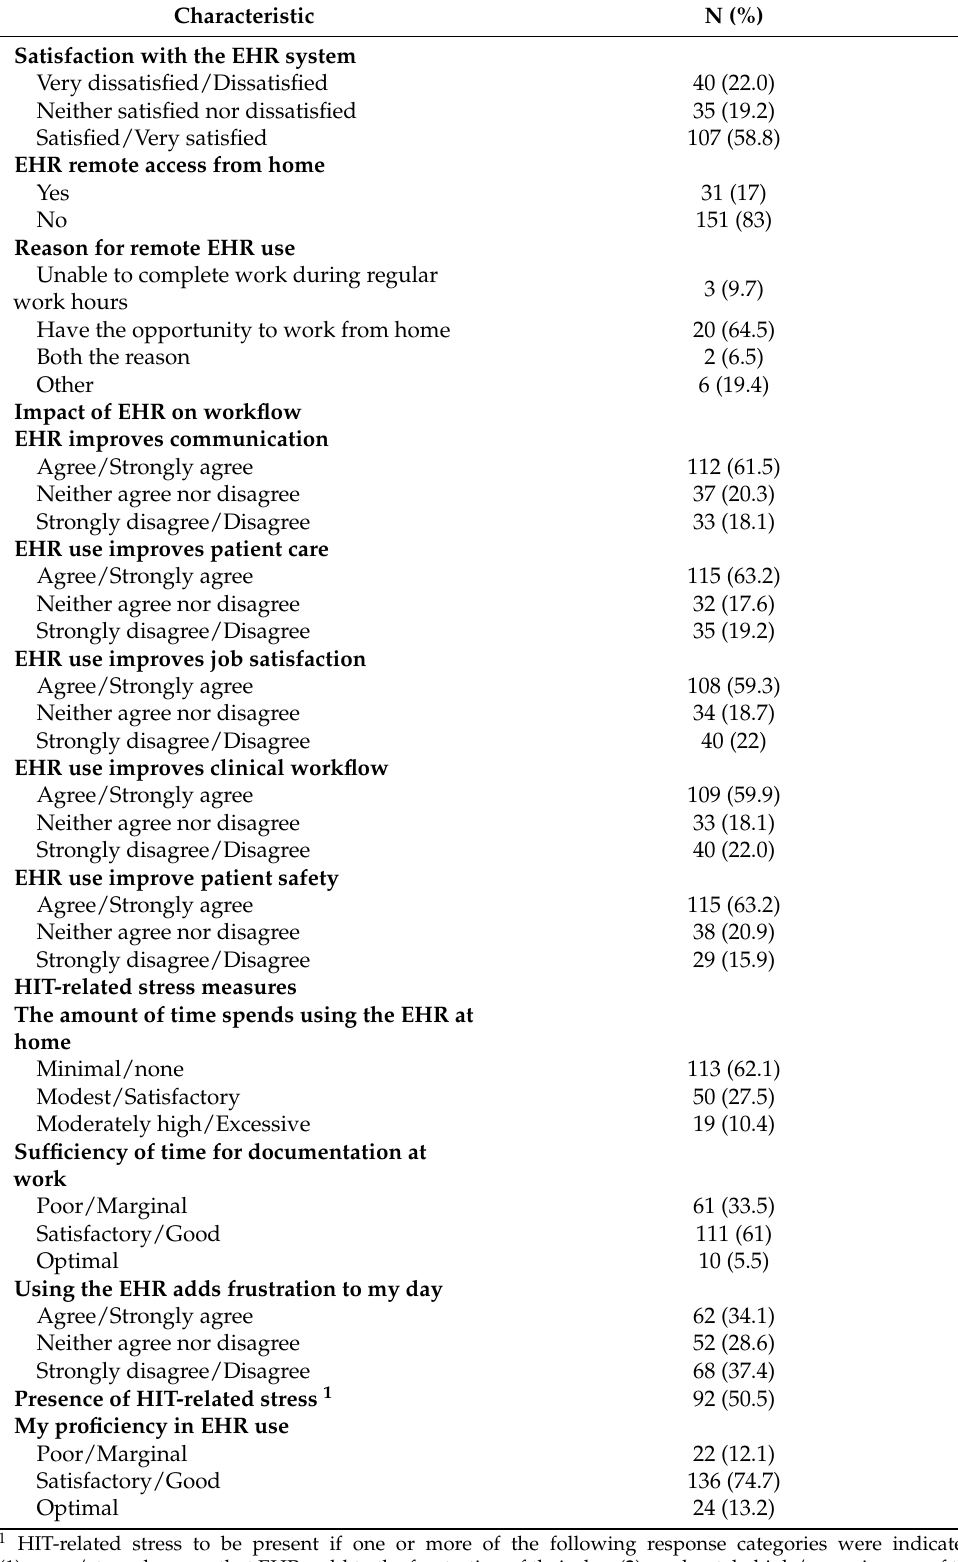
Table 2. HIT characteristics among participants (N =